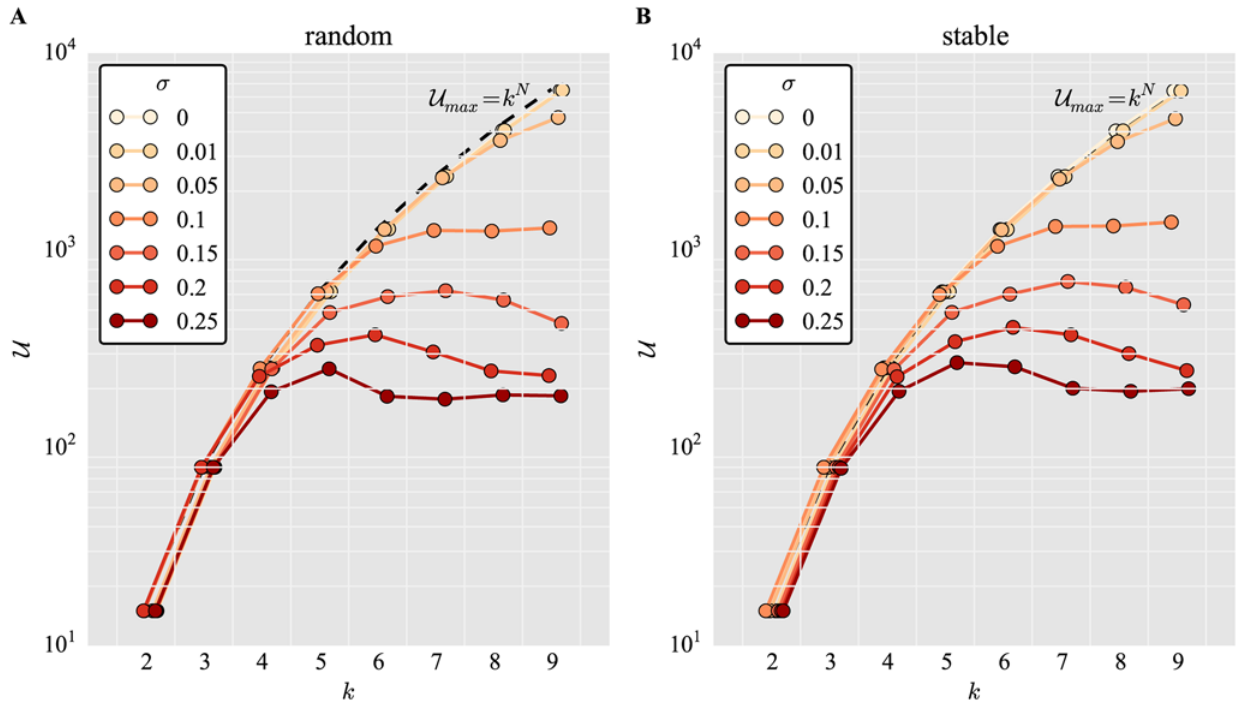
Fig 6. Noise decreases the number of phenotypes accessible by real-valued networks. Number of unique phenotypes U accessed for different numbers of gene expression states k and varying degrees of noise σ , for (A) random networks and (B) networks pre-selected for stability. Networks are real- valued, W r , network size N = 4, s off = 0, maximum of T = 100 iterations, and sample size λ = 1.7 × 10 6 . Jitter was added to values on the x-axis to avoid overlap of markers. Dashed lines represent the size of phenotype space: U max = k 4